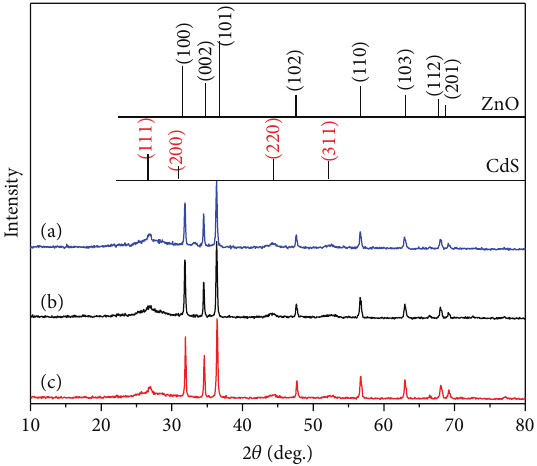
Figure 3: XRD patterns of (a) ZnO/CdS/BC hybrid fiber (50%), (b) ZnO/CdS/BC hybrid fiber (20%), and (c) ZnO/CdS/BC hybrid fiber